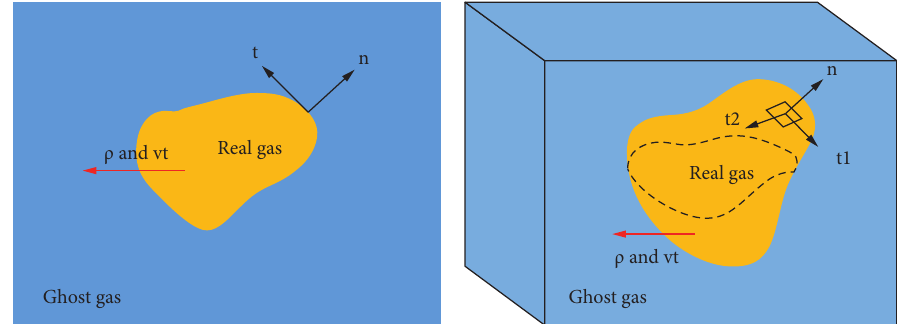
Figure 3: Extrapolation of density and tangential velocity in 2D and 3D implementation of DGFM.